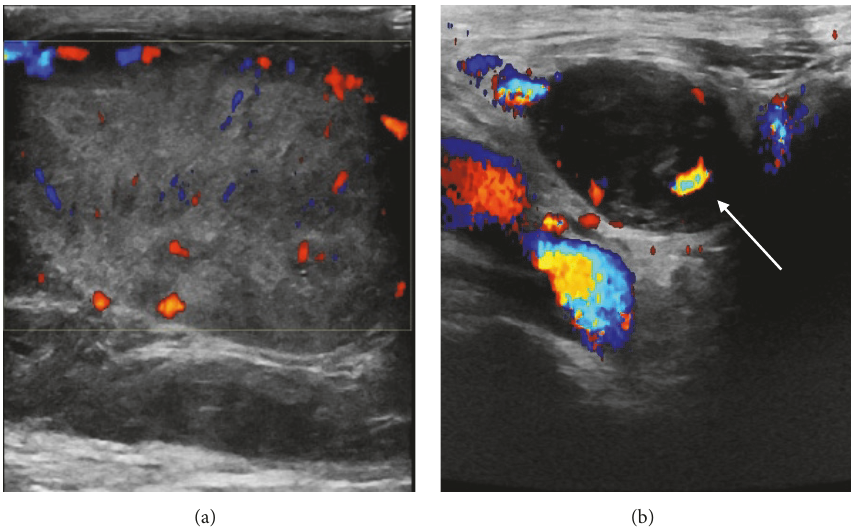
Figure 8: (a) Ultrasound of the scrotum demonstrates an enlarged diffusely heterogeneous right testicle and epididymis with areas of increased vascularity. (b) Ultrasound of the right spermatic cord at the level of the right inguinal canal. Image demonstrates a tubular predominantly hypoechoic mass with internal vascularity (white